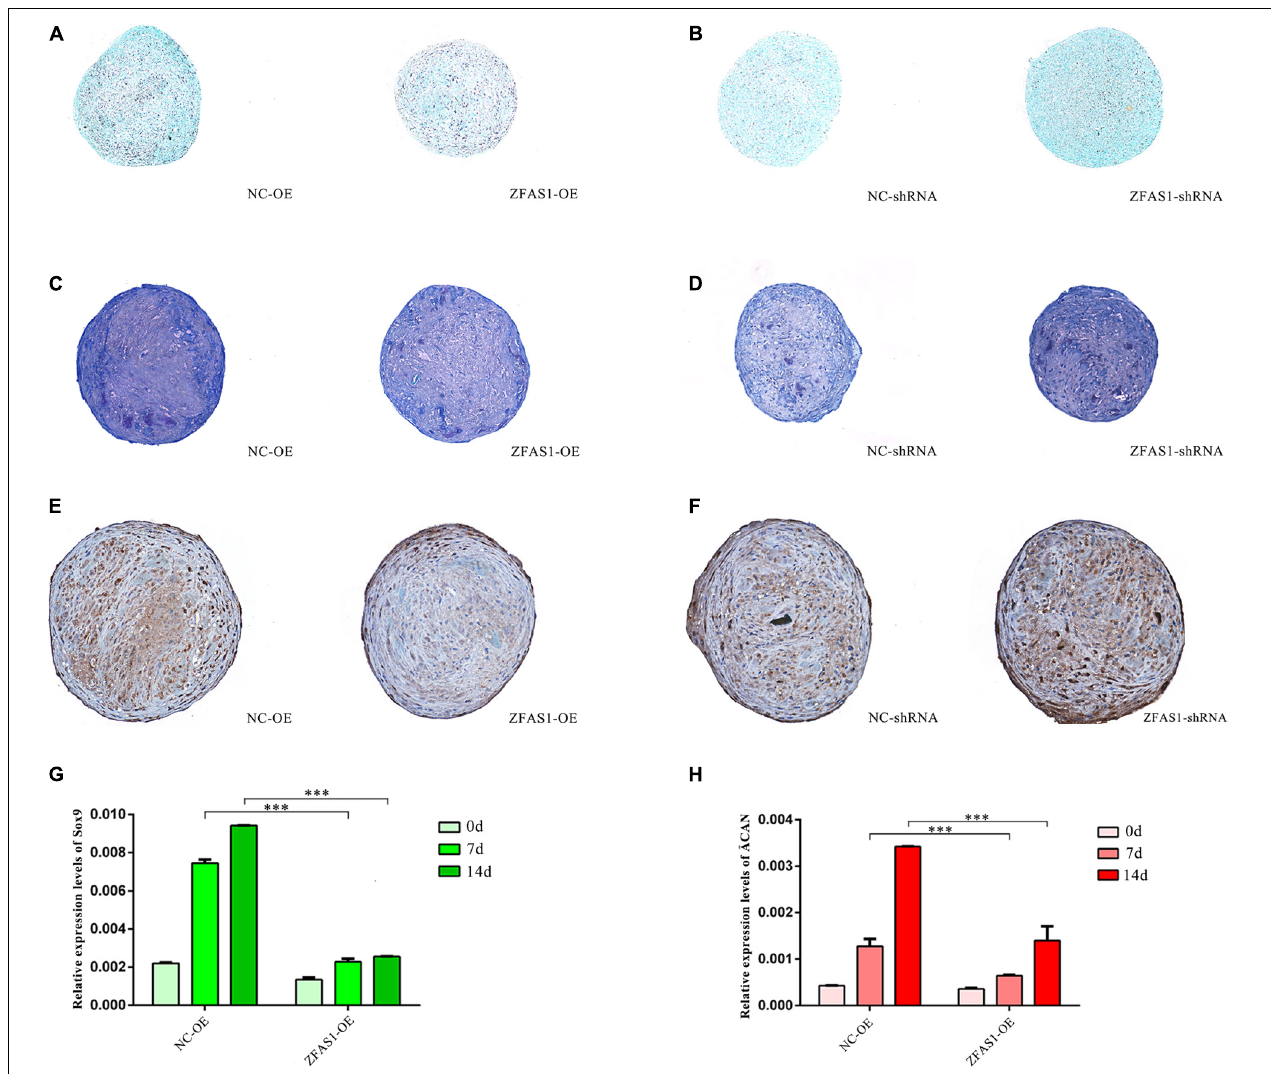
FIGURE 3 | ZFAS1 overexpression suppressed the chondrogenic differentiation potential in human umbilical cord mesenchymal stem cells (HUC-MSCs). (A,B) Alcian blue staining of paraffin sections from chondrocyte pellets revealed a negative regulation of chondrogenic differentiation by ZFAS1. The color depth of Alcian blue indicates the levels of chondrogenic differentiation. (C,D) Toluidine blue staining of paraffin sections from chondrocyte pellets revealed a negative regulation of chondrogenic differentiation by ZFAS1. The color depth of toluidine blue indicates the levels of chondrogenic differentiation. (E,F) The immunohistochemistry (IHC) results of collagen type II in the paraffin sections from chondrocyte pellets. The brown regions represent the signal of collagen type II; the blue dots represent the signal of nuclei. (G,H) The qPCR assay showed that ZFAS1 overexpression downregulated the expression of Sox9 and ACAN in the chondrogenesis-induced pellets at 0/7/14 days. Values are mean ± SEM, n = 3, *** P < 0.0001. d,